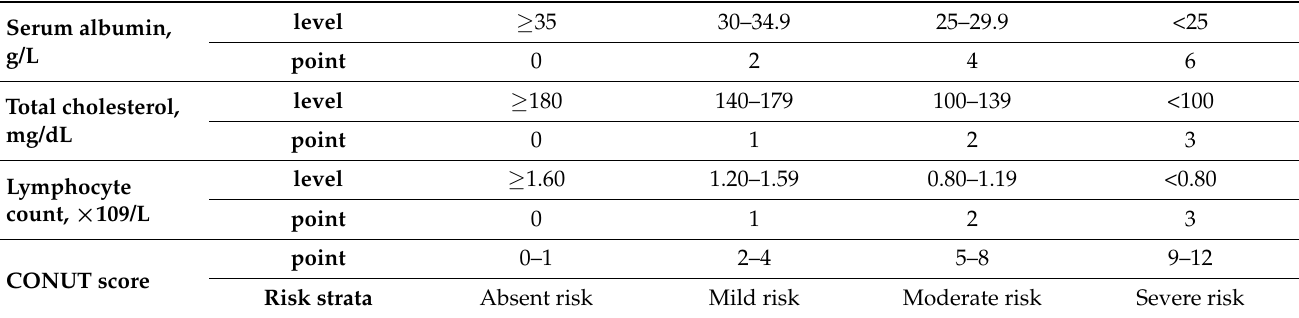
Table 1. Details of the CONUT scoring